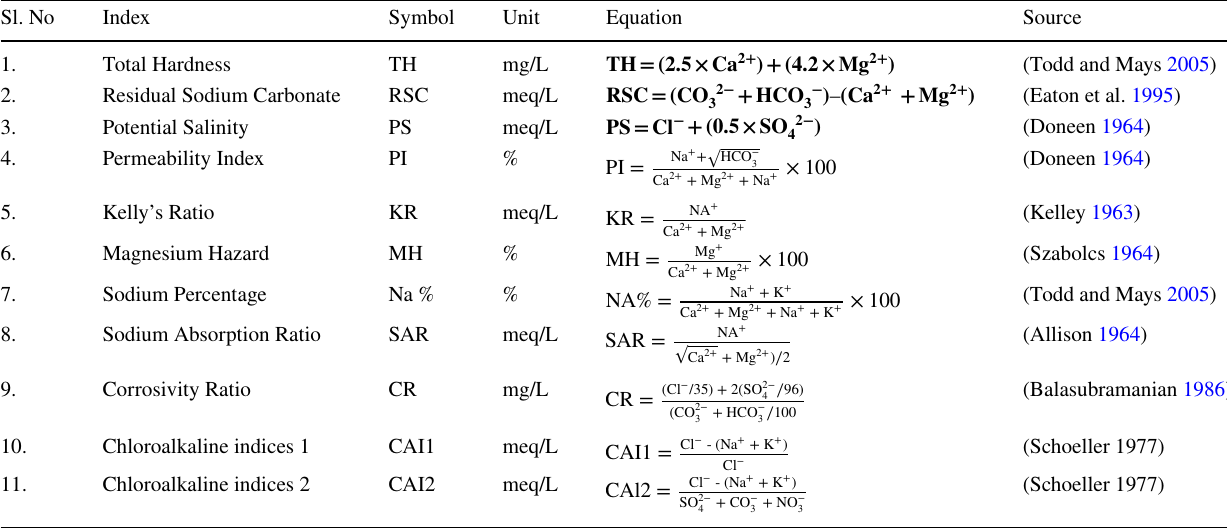
Table 3 Different indices/parameters used for evaluation of water quality Sl. No